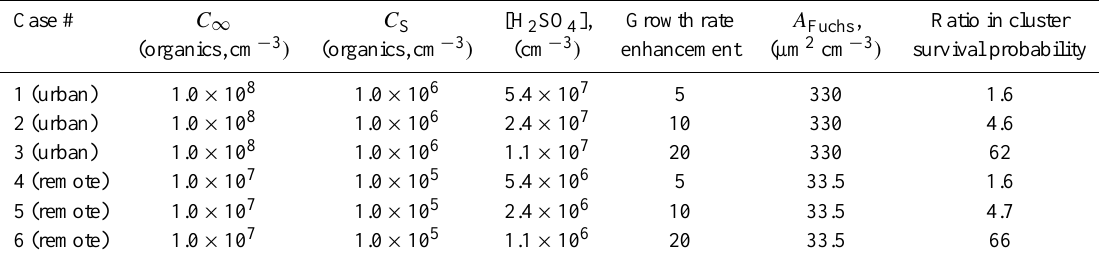
Table 2. The ratio of the cluster survival probability derived from GR eff to that based on GR cond under sulfuric acid and organics concentra- tions representative of NPF events. The survival probability is calculated for 1.5nm thermodynamically stable clusters growing to form 3nm